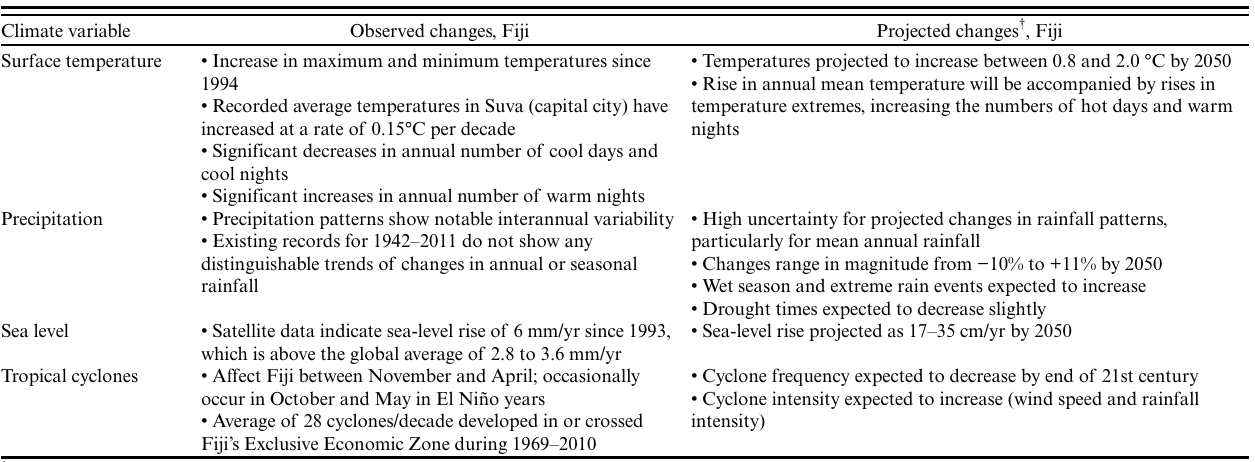
Table 2. Summary of observed and simulated changes in key climate variables for Fiji. Sources: Australian Bureau of Meteorology and CSIRO (2014), Australian Government (2015), Fiji Meteorological Service et al. (2015).